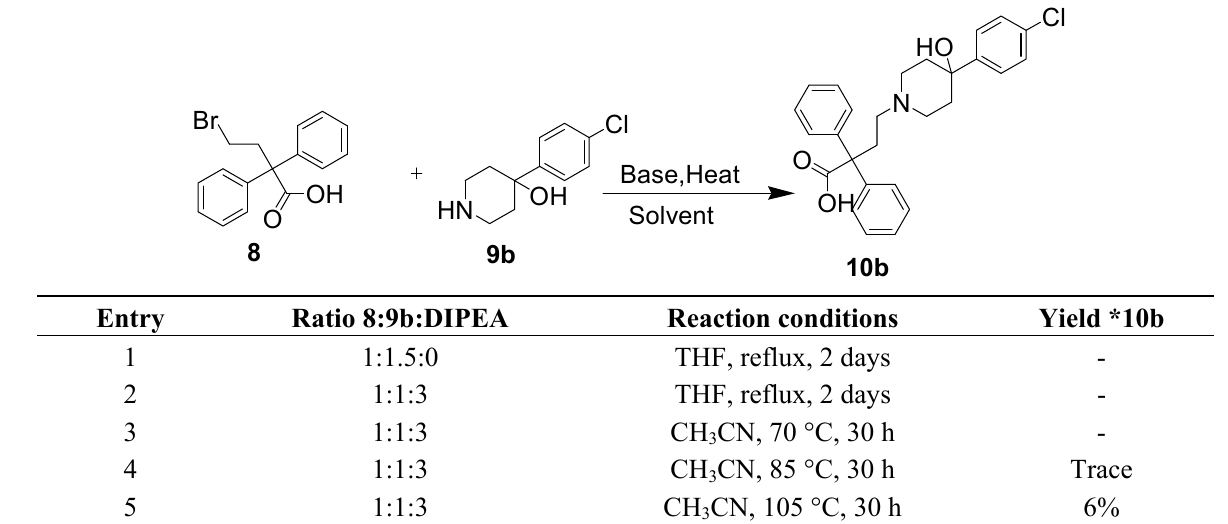
Table 1. Synthesis of the intermediate compound 10b